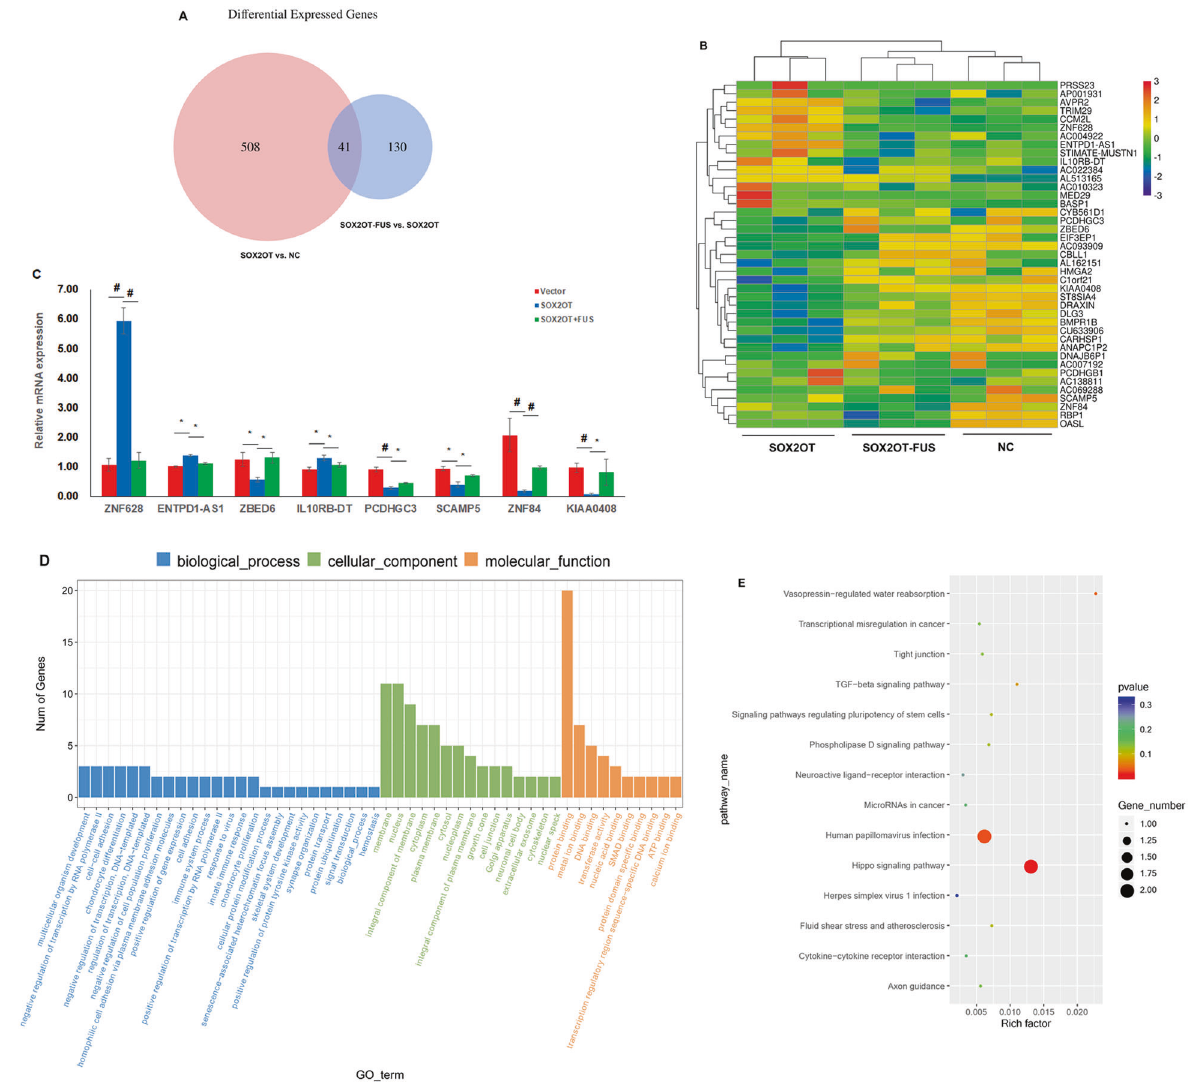
Fig. 5 The downstream target genes and signaling pathways regulated by SOX2OT – FUS axis. A Venn diagram showing that the overlapped genes between the differentially expressed genes of PANC-1 – SOX2OT & PANC-1 – Vector and PANC-1 – SOX2OT – FUS & PANC- 1 – SOX2OT by RNA-seq. B A heatmap showing 41 differentially expressed genes may be regulated by SOX2OT – FUS axis. C qRT-PCR validation of the expression changes of several SOX2OT – FUS axis regulated genes that have been implicated in cancer. * represents p < 0.05, # represents p < 0.001, compared with the control group. D The histogram of Gene Ontology (GO) enrichment analysis results re fl ects the number distribution of genes with signi fi cant differences in GO term enriched by biological process, cellular component, and molecular function. E ggplot2 is used to display the KEGG pathway enrichment analysis results in a scatter diagram. Rich factor indicates the number of differential genes located in the KEGG/the total number of genes located in the KEGG. The greater the rich factor value, the greater the KEGG enrichment degree. In the scatter diagram, the size of the point represents S gene number, the color of the point represents the p value of enrichment analysis, that is, the signi fi cance of enrichment, and p value less than or equal to 0.05 represents signi fi cant